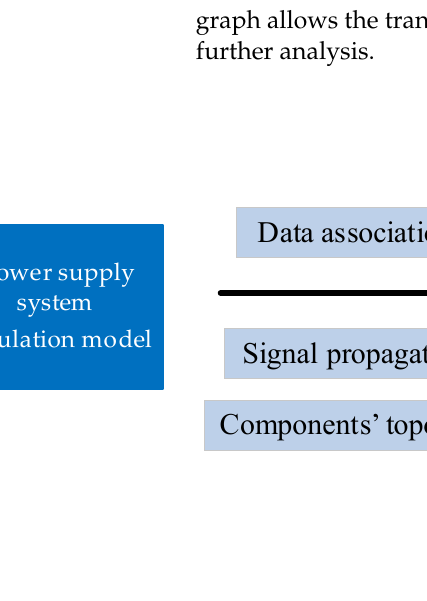
Figure 4. Reconstruction and reduction of the power supply system association graph model. The graph model visually represents and structures the associations between com- ponents through nodes and edges so that the graph model can be used as an identification criterion for different fault modes. Thus, the identification of associated fault modes can be realized in Section 4. 3.2. Enhancement of Component Associated Knowledge Based on the Warshall Algorithm The associated faults in the power supply system are often caused by the transmis- sion of fault signals from the fault source to the associated components, resulting in a drift in the monitoring signals of the components. Additionally, this causes association alarms, making it difficult to identify the fault source and diagnose the fault mode. However, the topology of the power supply system is already determined. When the data are incom- plete, it is difficult to fully explore the associations between the components due to the influence of monitoring noise and the uncertainty of the operating mode present in the data. The situation gets worse when the knowledge is incomplete as well. Although the association graph model of the power supply system developed in 3.1 can locate the fault source to a certain extent, the presence of the power controller still often affects or hinders the propagation of the fault signals due to the complexity of the associated faults. In the association fault model, there will always be components associated with the power sup- ply system outside of its physical structure. Therefore, it is necessary to enhance the asso- ciation knowledge based on component anomaly detection.